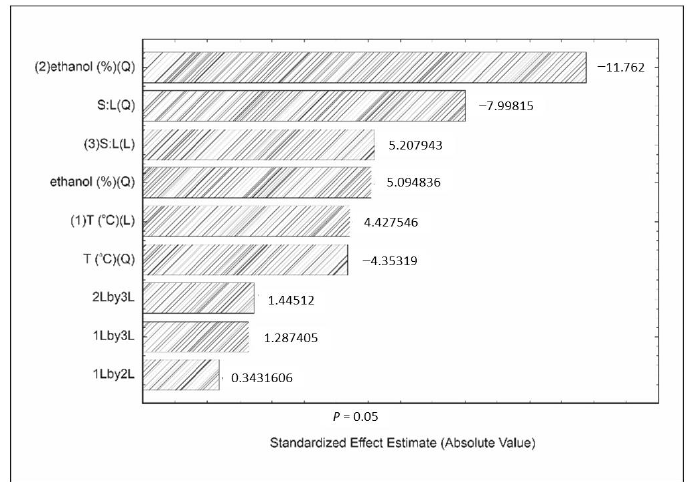
ture (T) and solid:liquid ratio (S:L).